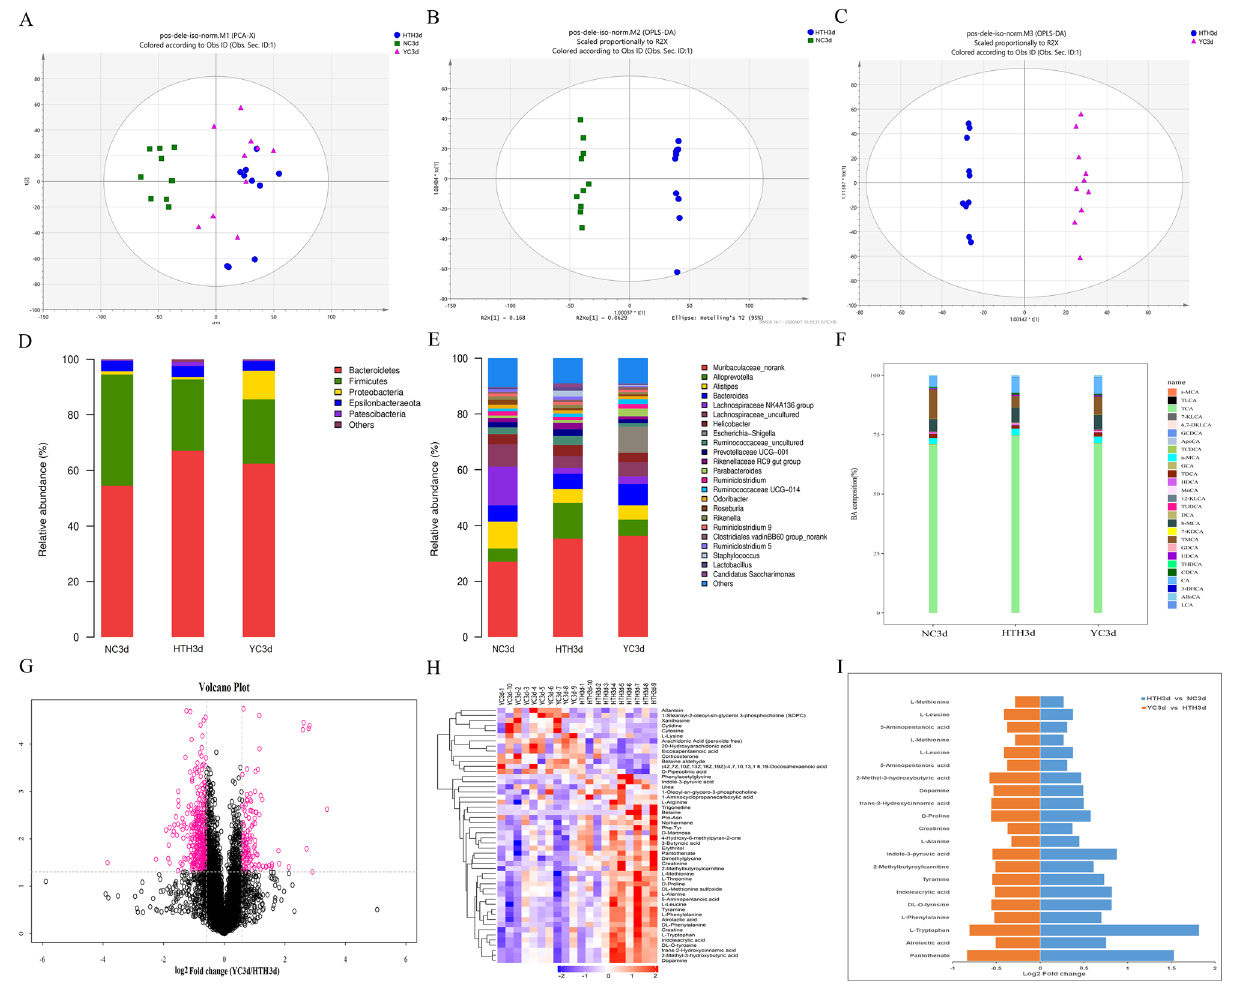
Figure 6. PCA scatter plot of the metabolite spectrum. ( A ) The NC group, HTH group, and YC group are separated from each other. OPLS-DA analyzes the metabolite profile. The OPLS-DA score chart ( B ) shows a good distinction between the HTH group and the NC group, R2X = 0.464, R2Y = 0.992, Q2 = 0.637, p < 0.05. OPLS-DA score chart ( C ) and a good distinction between the HTH and YC groups, R2X = 0.464, R2Y = 0.992, Q2 = 0.637, p < 0.05.Microbial species classification histogram ( D , E ): From phylum ( D ) and genus ( E ), respectively, it was shown that after administration of HTH, the intestinal bacterial of the HTH group showed significant changes; while that of the Herb Yinchen group tended to return to normal. Based on the results of bile acid detection, a histogram ( F ) of bile acid pool composition is generated to visually show the proportion of various bile acids and the higher proportion of bile acids. Screening and changing characteristics of various metabolites in plasma exposed to HTH environment at different times. The volcano graph shows the difference between metabolites in YC3d_vs_HTH3d ( G ). The red dots in the figure are the metabolites with FC > 1.5 and p value < 0.05, that is, the differential metabolites screened by univariate statistical analysis. Hierarchical clustering heat map analysis of differential metabolites between YC3d_vs_HTH3d ( H ). Each column represents a sample, and each row represents a metabolite. The color of each part corresponds to the concentration value of each metabolite calculated by the peak area normalization method (red, up; blue, down). The bidirectional histogram ( I ) shows metabolites with a fold change > 1 in the HTH3d_vs_NC3d group, and metabolites with a fold change < 1 in the YC3d_vs_HTH3d